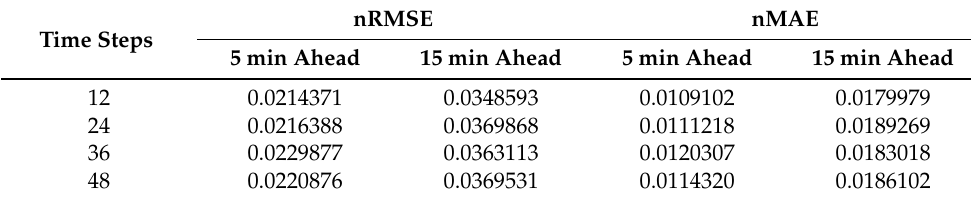
Table 3. Results of the very short-term forecasting error by varying the number of RNN time steps. Time Steps